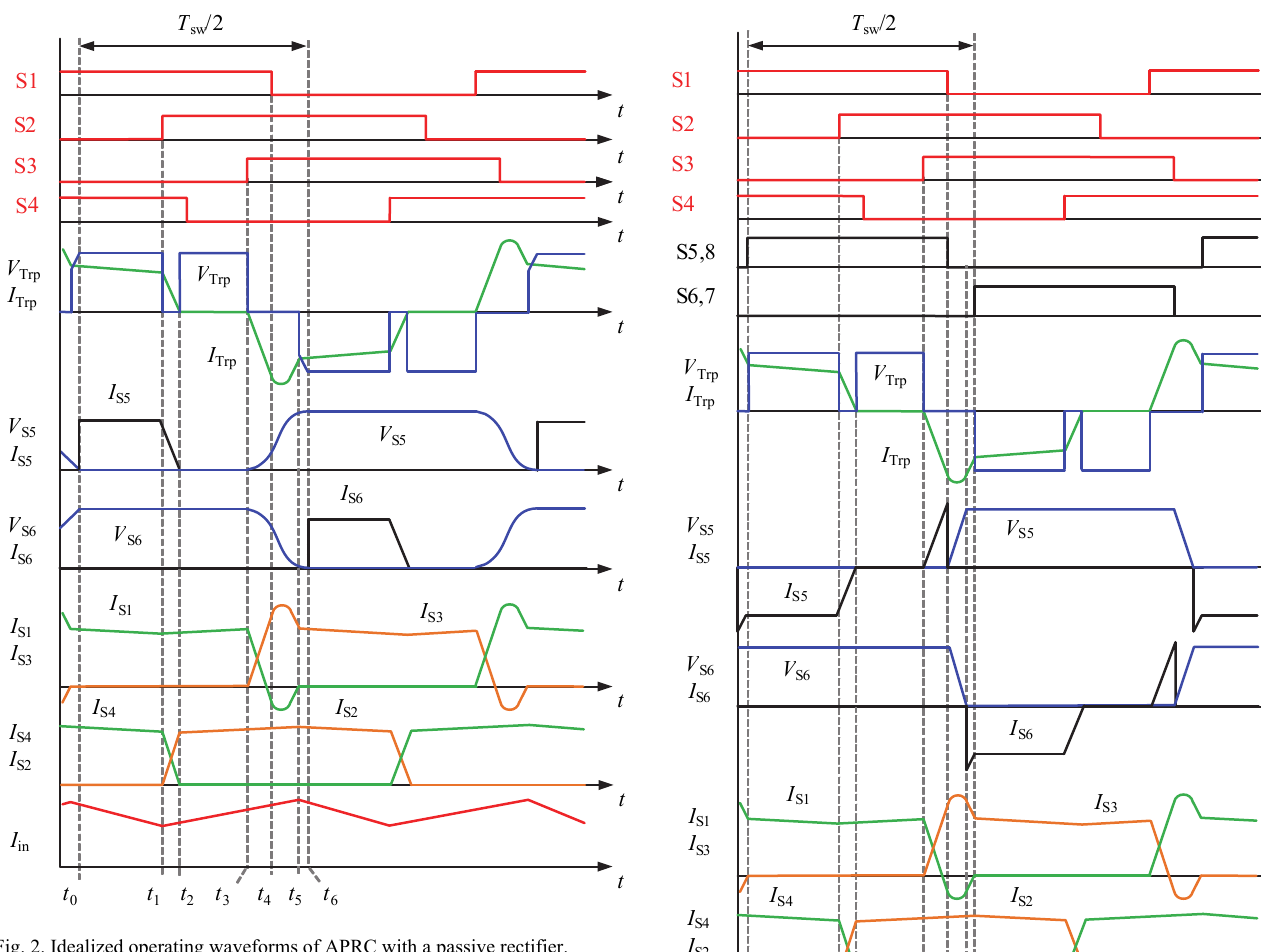
Fig. 2. Idealized operating waveforms of APRC with a passive rectifier.